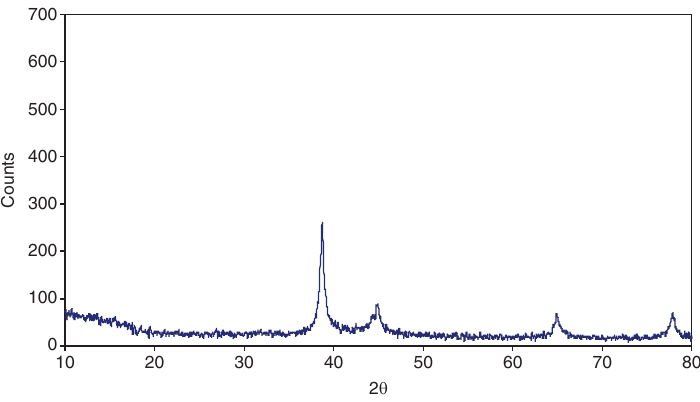
Figure 3 X-ray diffraction (XRD) of Ag-polyvinyl alcohol (PVA) bulk layers of the nanocomposite films.